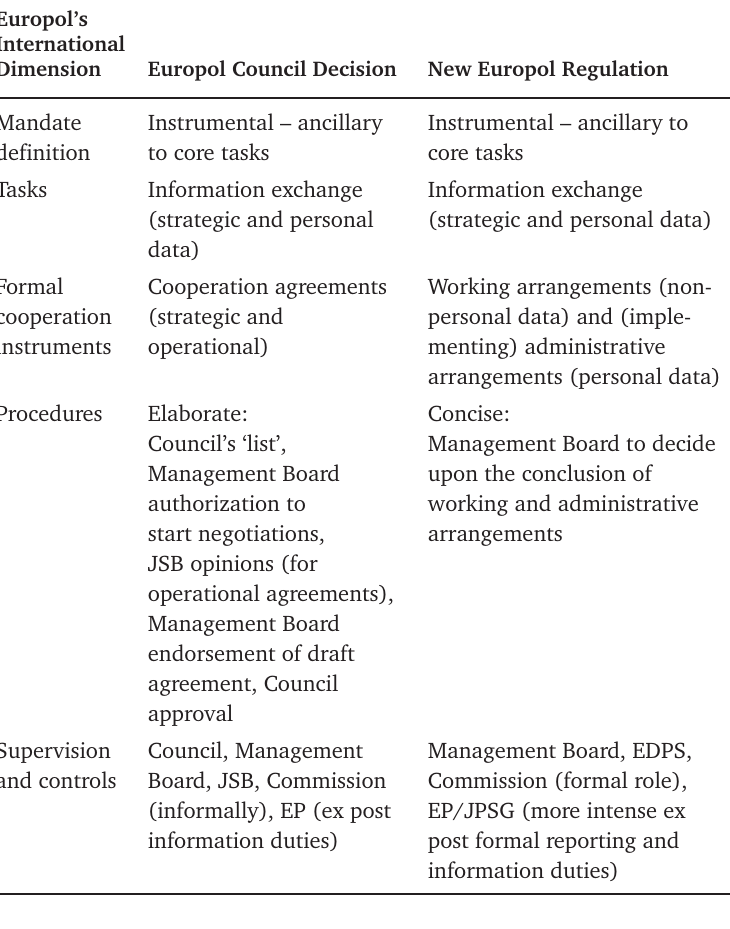
Table 1. Comparative overview of Europol’s international dimension under the Europol Council Decision and the new Europol Regulation Europol’s International